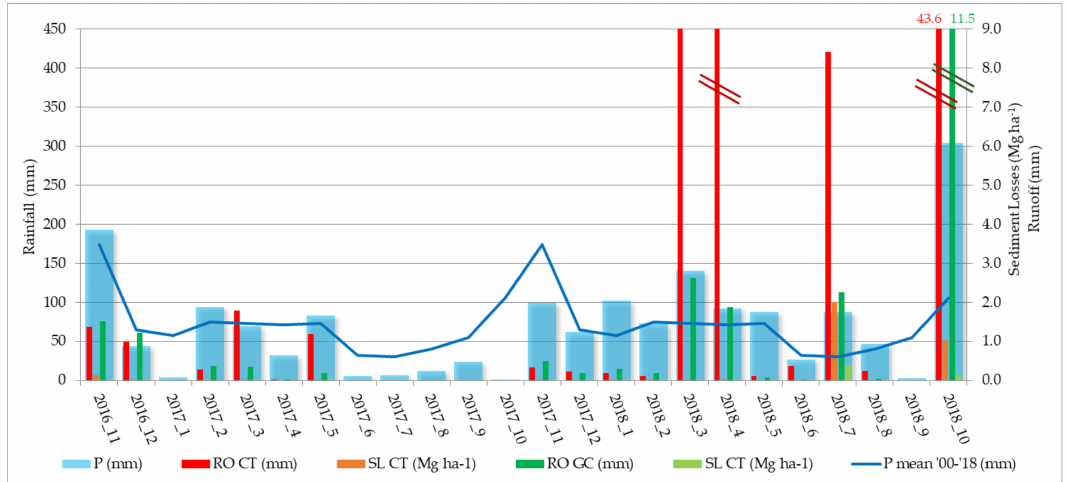
Figure 7. Monthly precipitation (P) and mean precipitation in 2000–2018 period (P mean), runo ff (RO), and soil loss (SL) in CT and